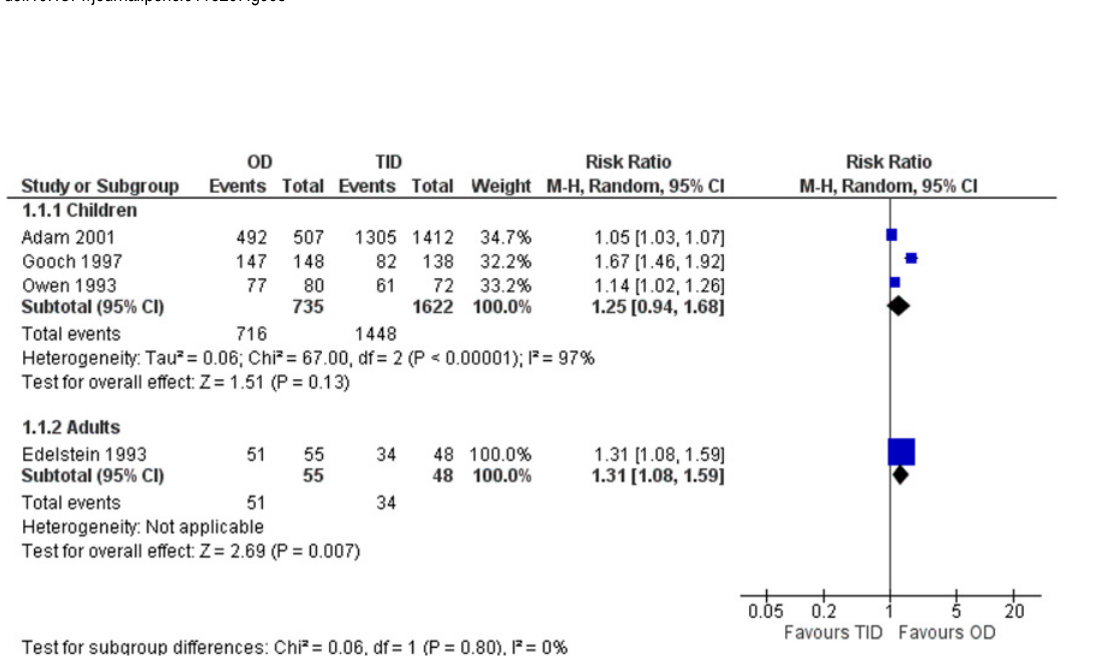
Figure 5. Forest plot depicting the risk ratios (RR) of compliance of patients receiving an antibiotic twice-daily versus the same antibiotic or antibiotic of the same class thrice-daily.